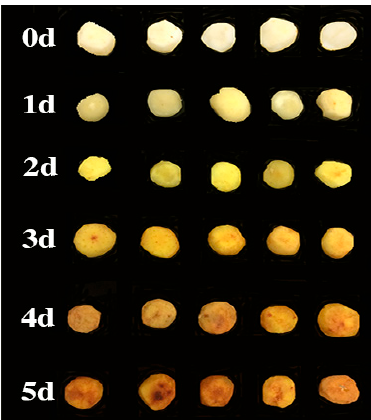
Figure 5. The yellowing process from the fresh-cut Chinese water chestnut. Each day has 5 replicate samples.